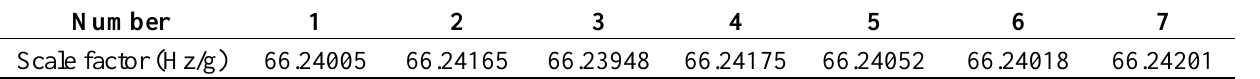
Table 4. The scale factors of the seven measurements for one start-up.